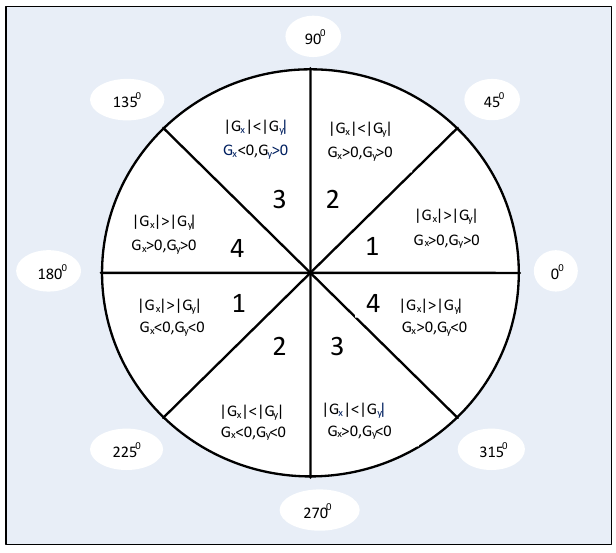
Figure 8. Eight gradient directions division